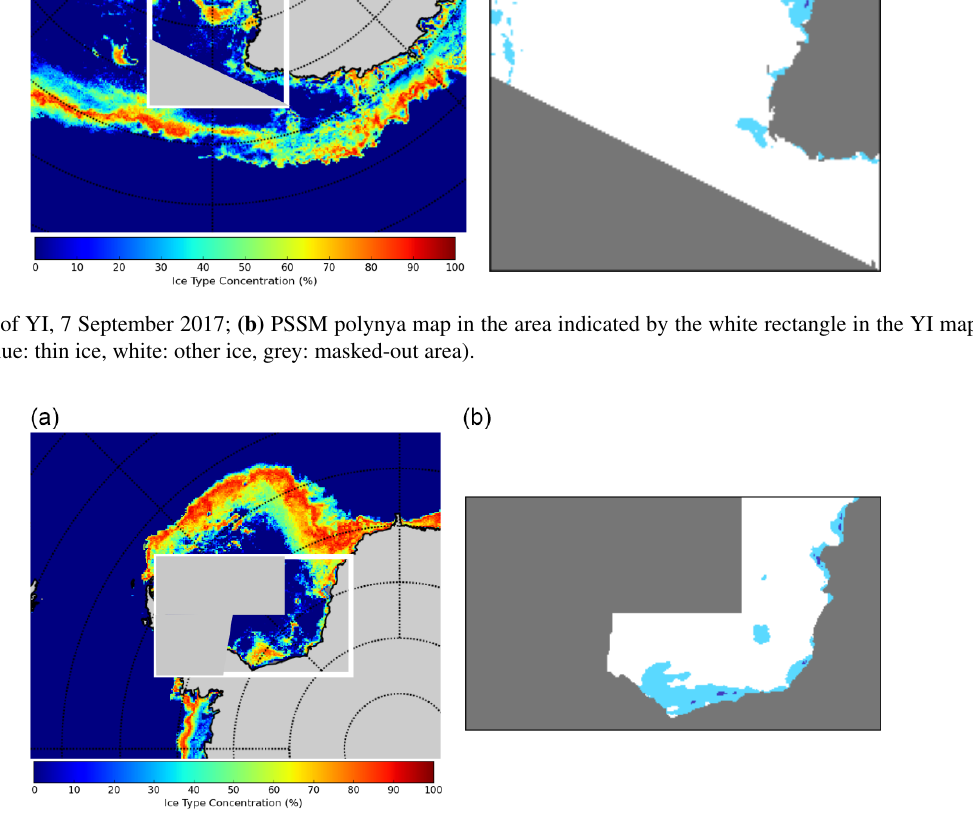
Figure 9. (a) Map of YI, 2 May 2017; (b) PSSM polynya map in the area indicated by the white rectangle in the YI map (dark blue: open water, light blue: thin ice, white: other ice, grey: masked-out